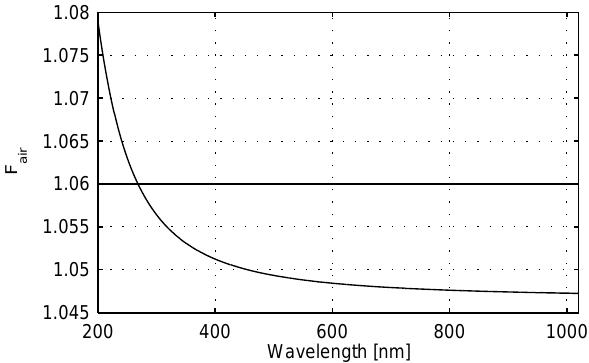
Figure 1. The wavelength-dependent King factor F air (Bodhaine et al., 1999), together with the commonly used value of